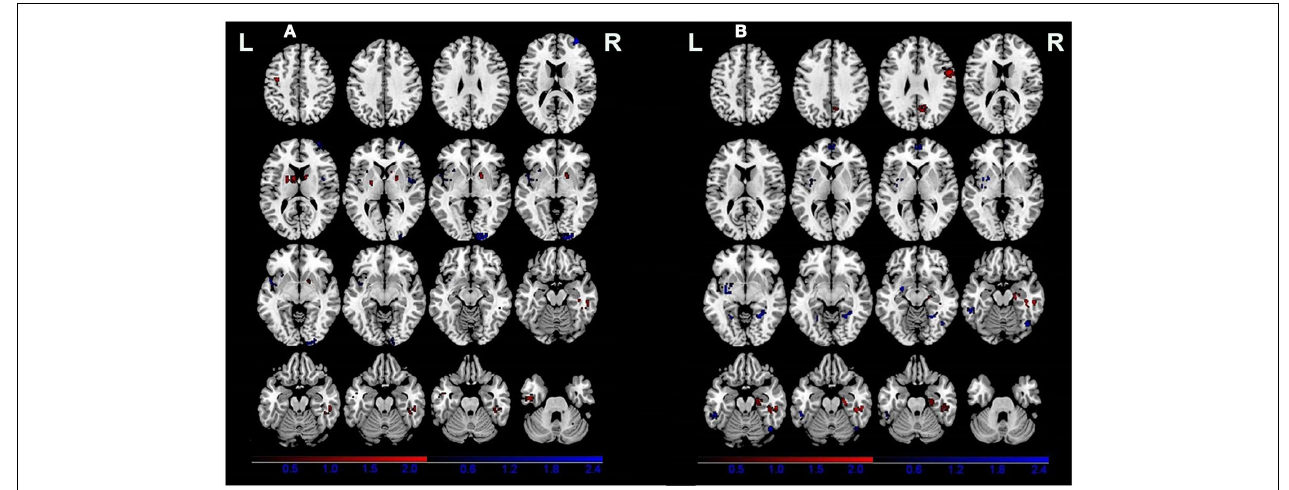
FIGURE 2 | Gray matter differences between patients (A) and relatives of patients (B) compared with healthy controls . Areas with increased gray matter relative to controls are displayed in red, and areas with decreased gray matter are displayed in